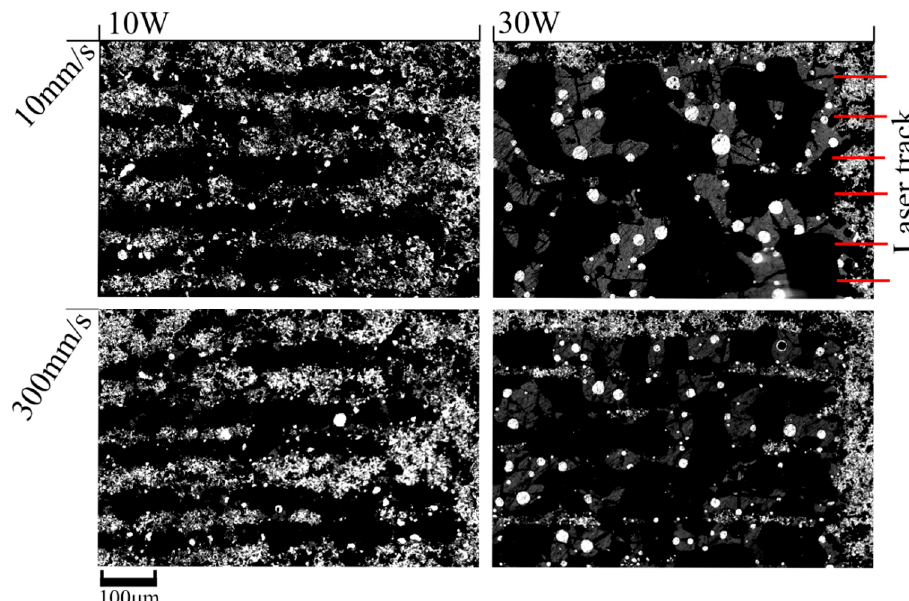
Figure 4. The change in composition of the film due to ablation. Light areas denote metallic areas and the darker areas denote exidise areas. Laser power is increased from (left) 10 W to (right) 30 W. Scanning speed is increased from (top) 10 mm/s to (bottom) 300 mm/s. This corresponds to an applied fluence of ( top left ) 5 J·mm − 2 , ( top right ) 15 J·mm − 2 , ( bottom left ) 0.17 J·mm − 2 , and ( bottom right ) 0.5 J·mm − 2 .